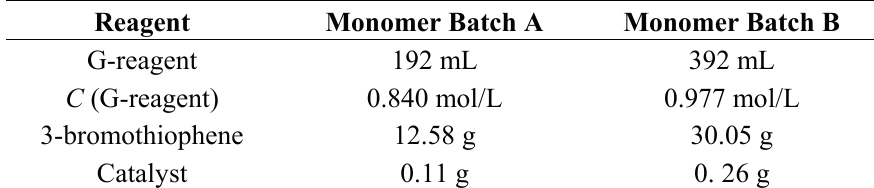
Table 2. The amounts of used reagents in monomer batches A and